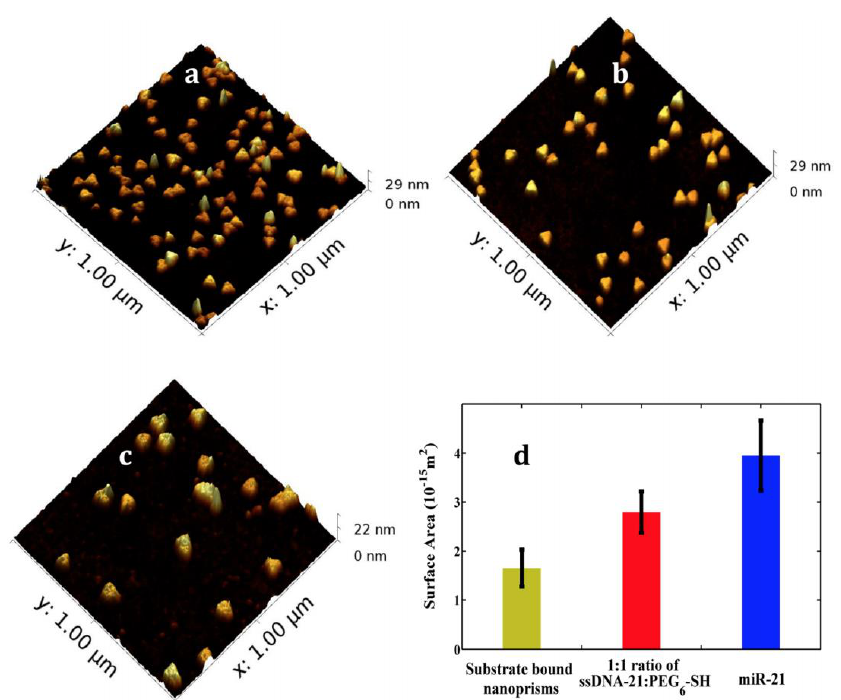
Figure 13. Surface modification of LSPR sensor. ( a ) AFM micrographs after functionalization with 1:1 ratio of HS-C6-ssDNA-21/PEG6-SH ( b ) and after hybridization with 100 nM miR-21 in 40% human plasma. ( c ) bare gold nanoprisms. ( d ) plot of the change in surface area of the gold nanoprisms after each surface modification. Reproduced with permission from [62]. Copyright American Chemical Society, 2014.